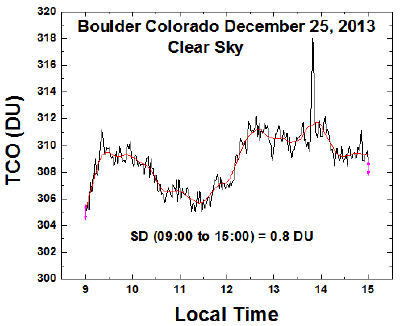
Figure 13. Pandora-retrieved TCO under clear-sky conditions as shown in Fig. 8 and a Lowess(0.2) fit (red curve) to the TCO